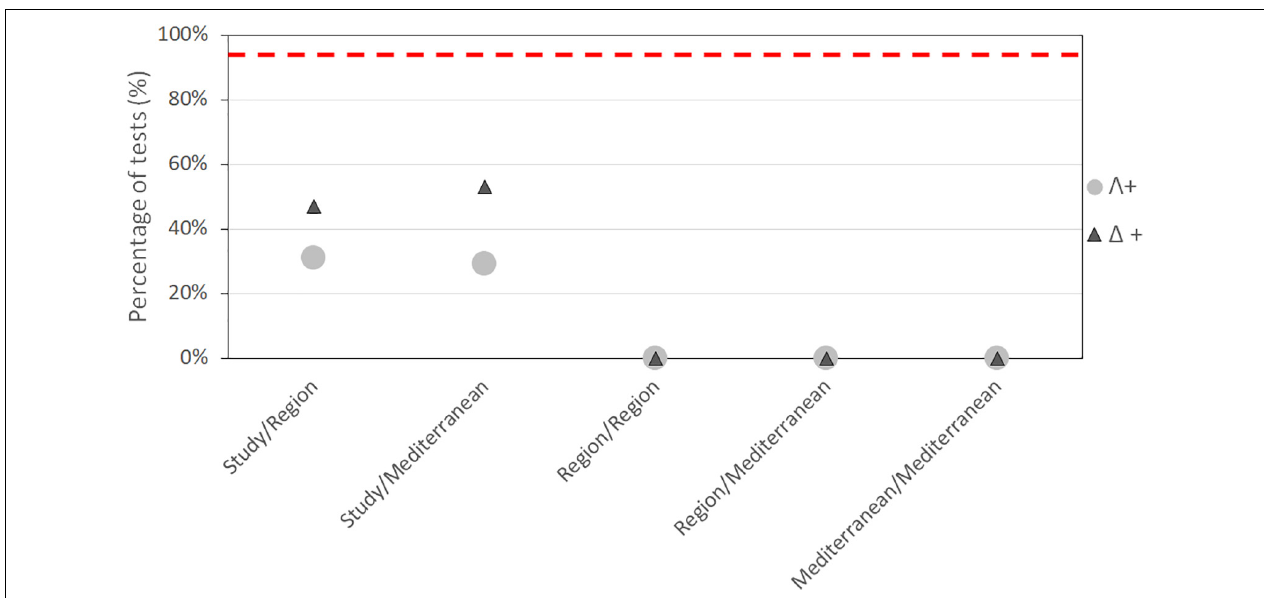
FIGURE 8 | Summary of randomization tests at all spatial scales. Values on the y-axis show the percentage of species lists for which the calculated taxonomic relatedness indices values ( (cid:49) + and (cid:51) +) fall within the 95% confidence limits of the simulated funnels. The dashed line represents the 95% threshold for which it might be reasonable to assume that the hypothesis of assembly at random cannot be